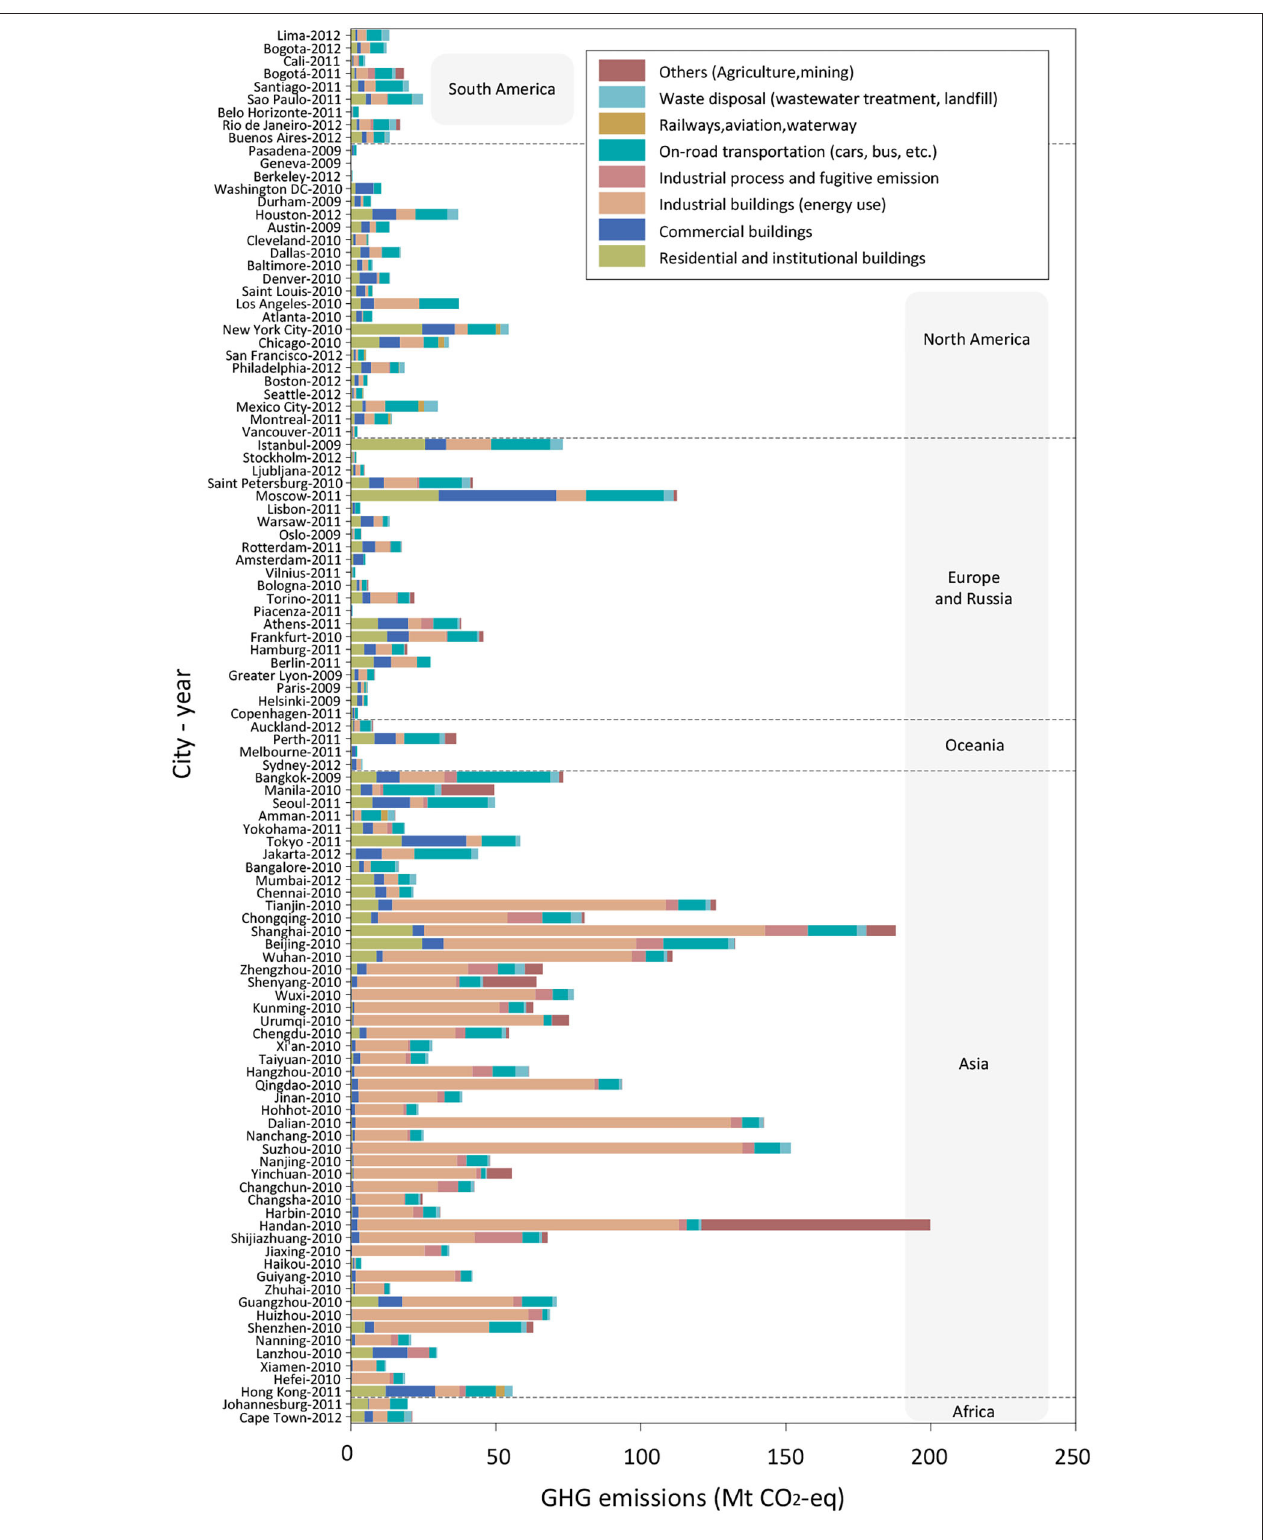
FIGURE 2 | Sector contribution to GHG emissions of global cities.